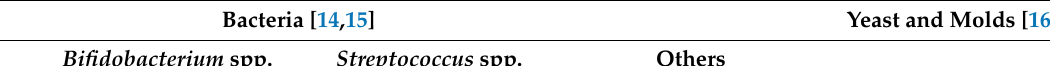
Table 1. Micro-organisms used as probiotics. Bacteria [14,15] Yeast and Molds [16] Lactobacillus spp. Bifidobacterium